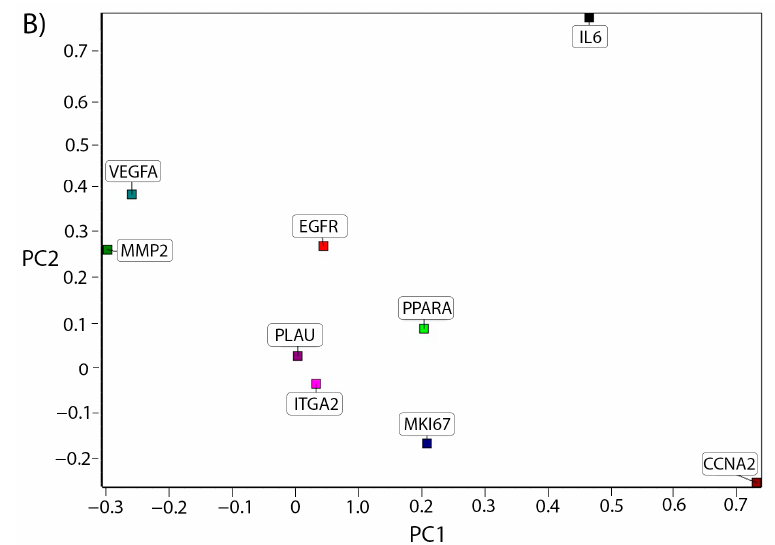
Figure 8. Principal component analysis of gene ‐ expression data is presented as sample scores ( A ), where each square represents a replicate sample, and gene loading, where each square represents a gene ( B ). Blue is 2D, Green is CNF_3.8, and Red is CNF_6.0. gene ( B ). Blue is 2D, Green is CNF_3.8, and Red is CNF_6.0.